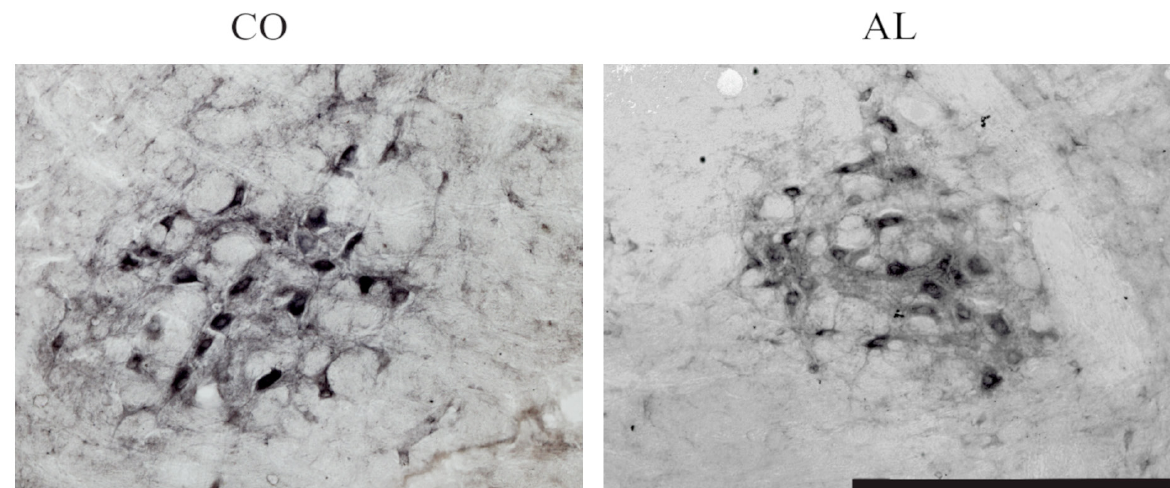
Figure 2. Dopamine immunoreactive cells in the VTA (black coloring) of animals in the following groups: Control (CO), and Alcohol (AL). Magnification: 200x; Scale bar: 300